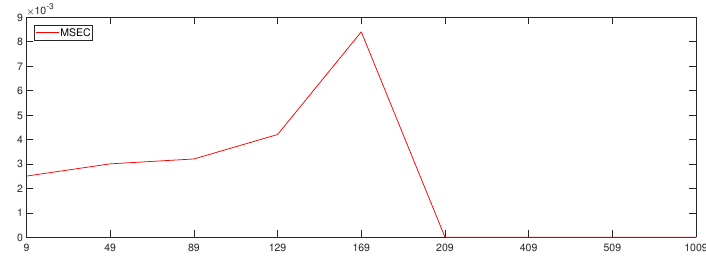
Figure 9. Folding line plot of the mean square error for a variance of 2.